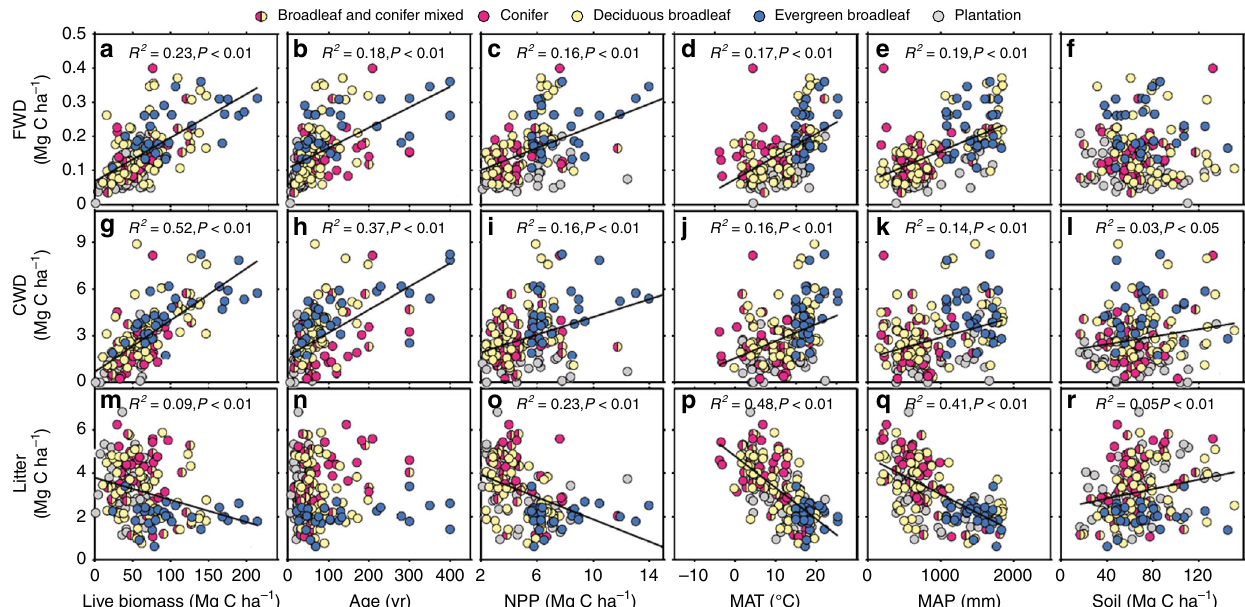
Fig. 3 Relationships between carbon density of dead organic matter, and biotic and climatic factors. The y axis is carbon density (Mg C ha − 1 ) of a – f fi ne woody debris ( FWD ), g – l coarse woody debris ( CWD ), and m – r litter. All plots showed the linear relationships between a , g and m above ground biomass carbon density, b , h and n forest age, c , i and o net primary production (NPP), d , j and p mean annual temperature ( MAT ), and e , k and q precipitation ( MAP ), and ( f , l and r ) soil carbon density and carbon density of each component of dead organic matter. There were no signi fi cant linear relationships between carbon density of litter and forest age, and between carbon density of FWD and carbon density of soil Table 2 Modeled carbon density and stock of the forest dead organic matter in China for the forest inventory periods of 1984 – 1988 and 2004 – 2008. For information about the carbon density and stock during the other inventory